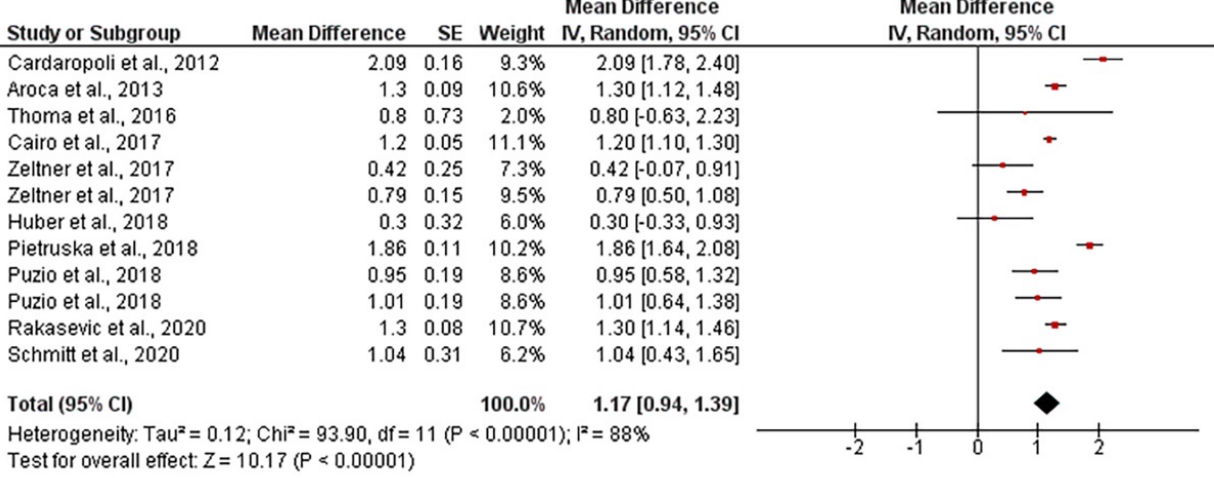
Figure 9. Forest plot for gingival thickness gain when autogenous connective tissue was used. The weighted mean is presented at CI 95%. Heterogeneity was determined using Higgins (I 2 ). A random-effects model was applied. Statistical significance was p < 0.001.